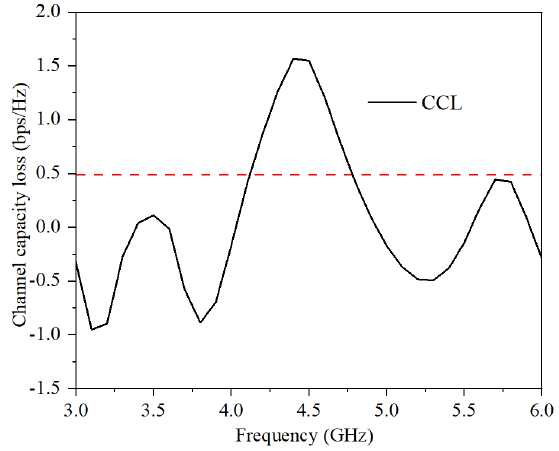
The calculated CCL of the proposed MIMO antenna system is shown in Figure 11. The values of CCL in the operating frequency bands are smaller than 0.5.